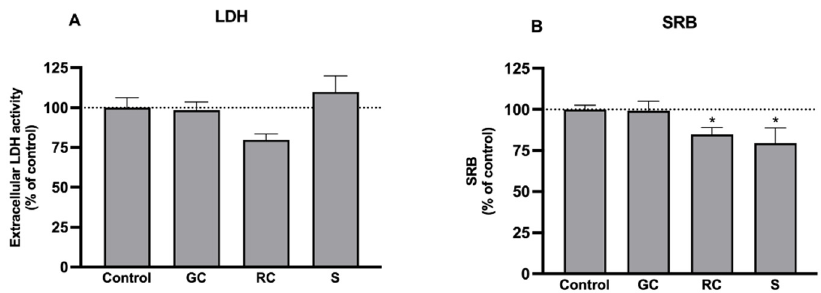
Figure 1. Effect of green coffee (GC), roasted coffee (RC), and coffee silverskin (S) extracts (1 mg/mL) on: ( A ) Caco-2 cell viability, determined by quantification of extracellular LDH activity, and ( B ) culture growth, determined with the SRB assay. Cells were cultured for 24 h in the presence of GC, RC, and S extracts ( n = 4–10) or the respective solvent (control; n = 8–10). The results are shown as arithmetic means ± SEM. *, significantly different from control ( p < 0.05; Student’s t -test).